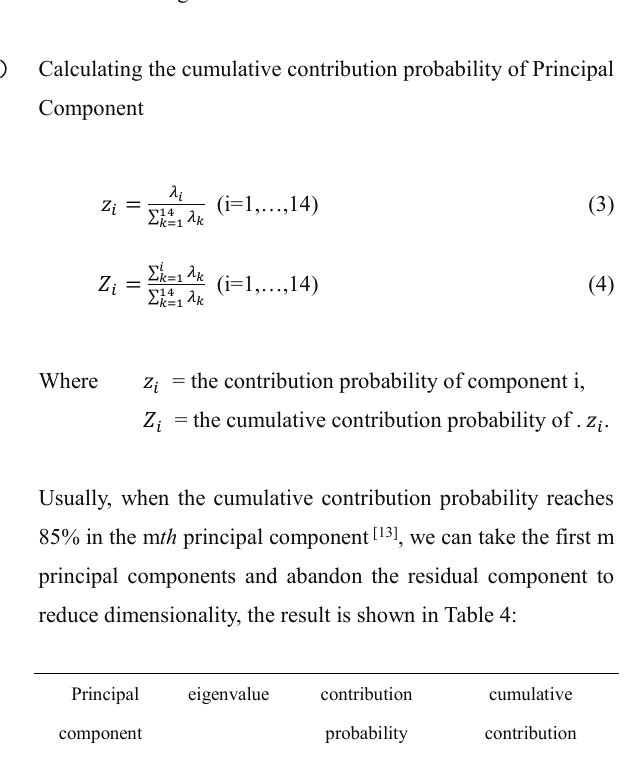
Table 3. Eigenvalues of Correlation Coefficient Matrix